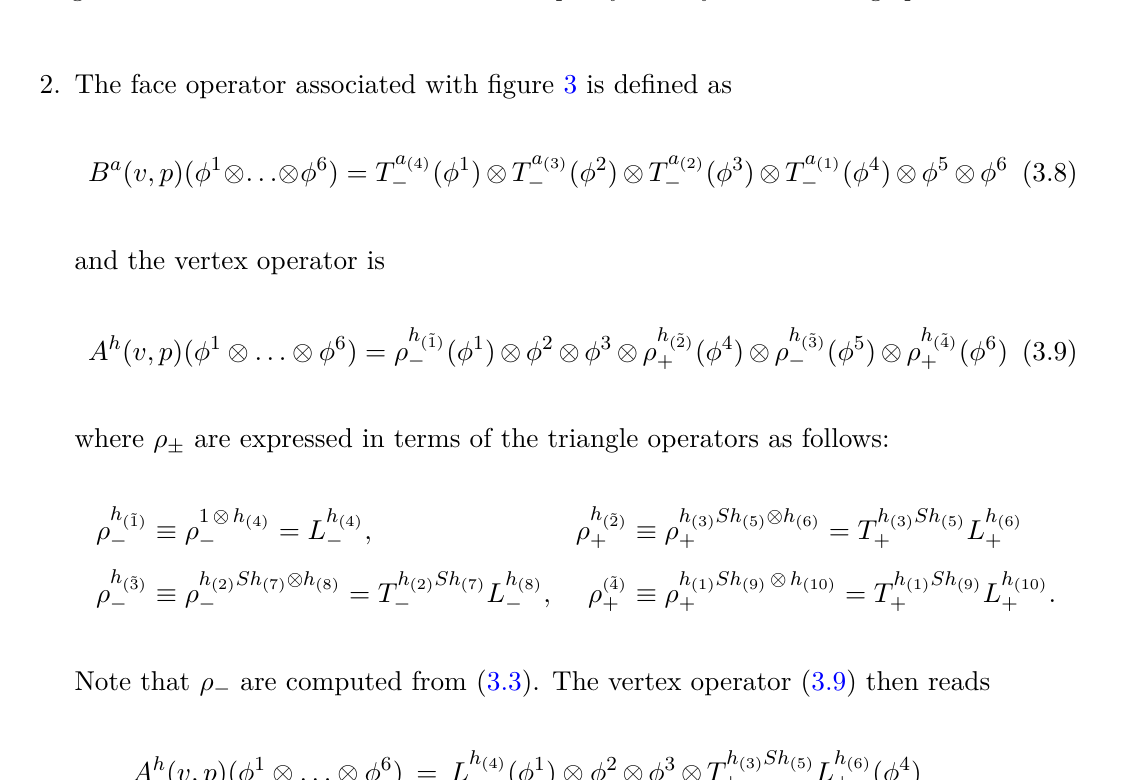
Figure 3 . We illustrate here a relevant subgraph of Γ , decorated by six copies of H ∗ which is the relevant structure for the proof of Theorem 3.3. Other orientations can be considered as well, but the argument follows in a similar manner. For simplicity we only focus on this